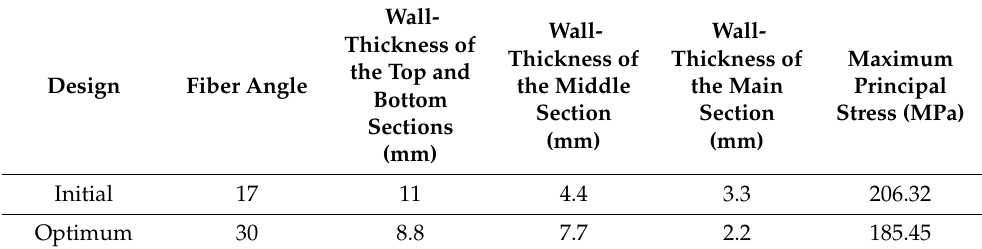
Table 5. A comparison among the parameters of initial and optimum designs of the composite CNG tank. CNG Design